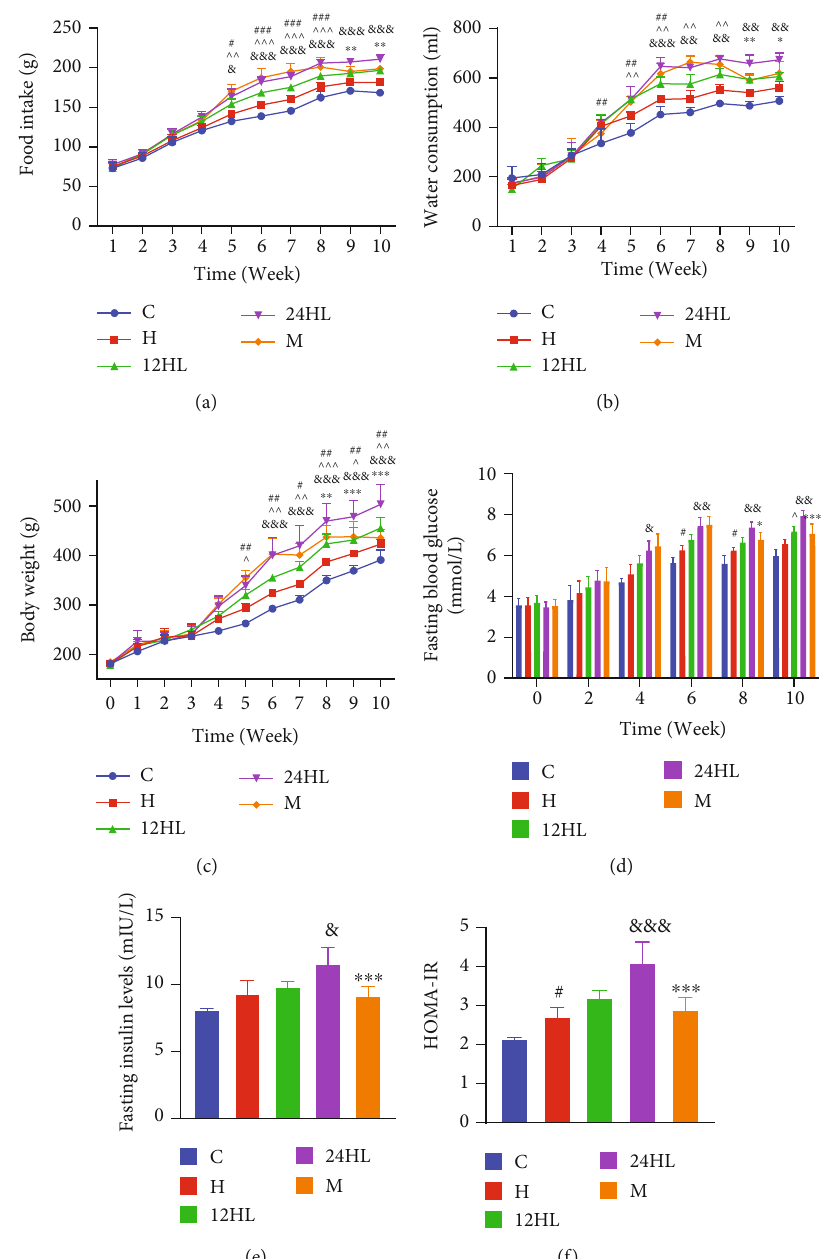
Figure 1: E ff ect of melatonin on food intake, water consumption, body weight, HOMA-IR, and fasting blood glucose and insulin levels. (a) Food intake, (b) water consumption, (c) body weight, (d) fasting blood glucose, (e) fasting insulin level, and (f) HOMA-IR. C: control group; H: HFD group; 12HL: 12 h light group; 24HL: 24h light group; M: melatonin group. The values are expressed as the means ± S : D : ( n = 7 – 12 per group). # P < 0 : 05 , ## P < 0 : 01 , and ### P < 0 : 001 , HFD vs. control; ^ P < 0 : 05 , ^^ P < 0 : 01 , and ^^^ P < 0 : 001 , 12HL vs. HFD group; & P < 0 : 05 , && P < 0 : 01 , and &&& P < 0 : 001 , 24HL vs. 12HL group; ∗ P < 0 : 05 , ∗∗ P < 0 : 01 , and ∗∗∗ P < 0 : 001 , M vs. 24HL